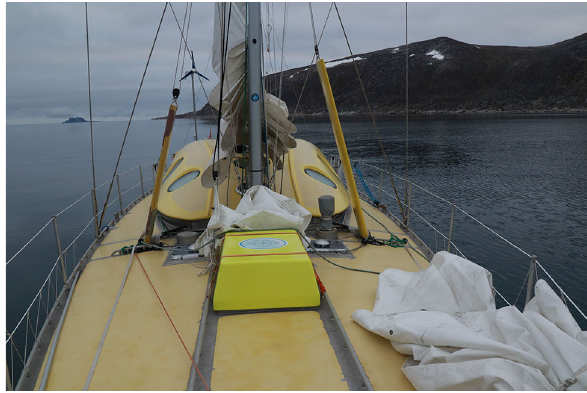
Fig. 10 Photo of the POLA-01 detector enclosed in its fiberglass yel- low hutch on the deck of the Nanuq sailboat. ( Photo by O. Pinazza. )